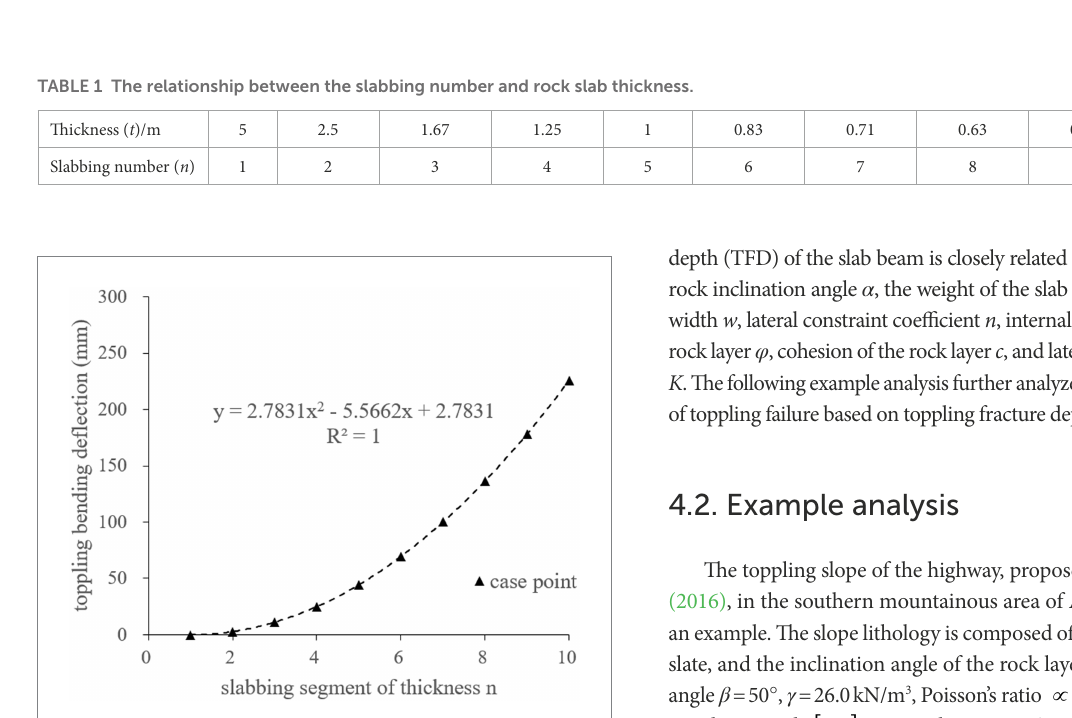
FIGURE 6 Relationship between the slabbing number and toppling bending deflection.